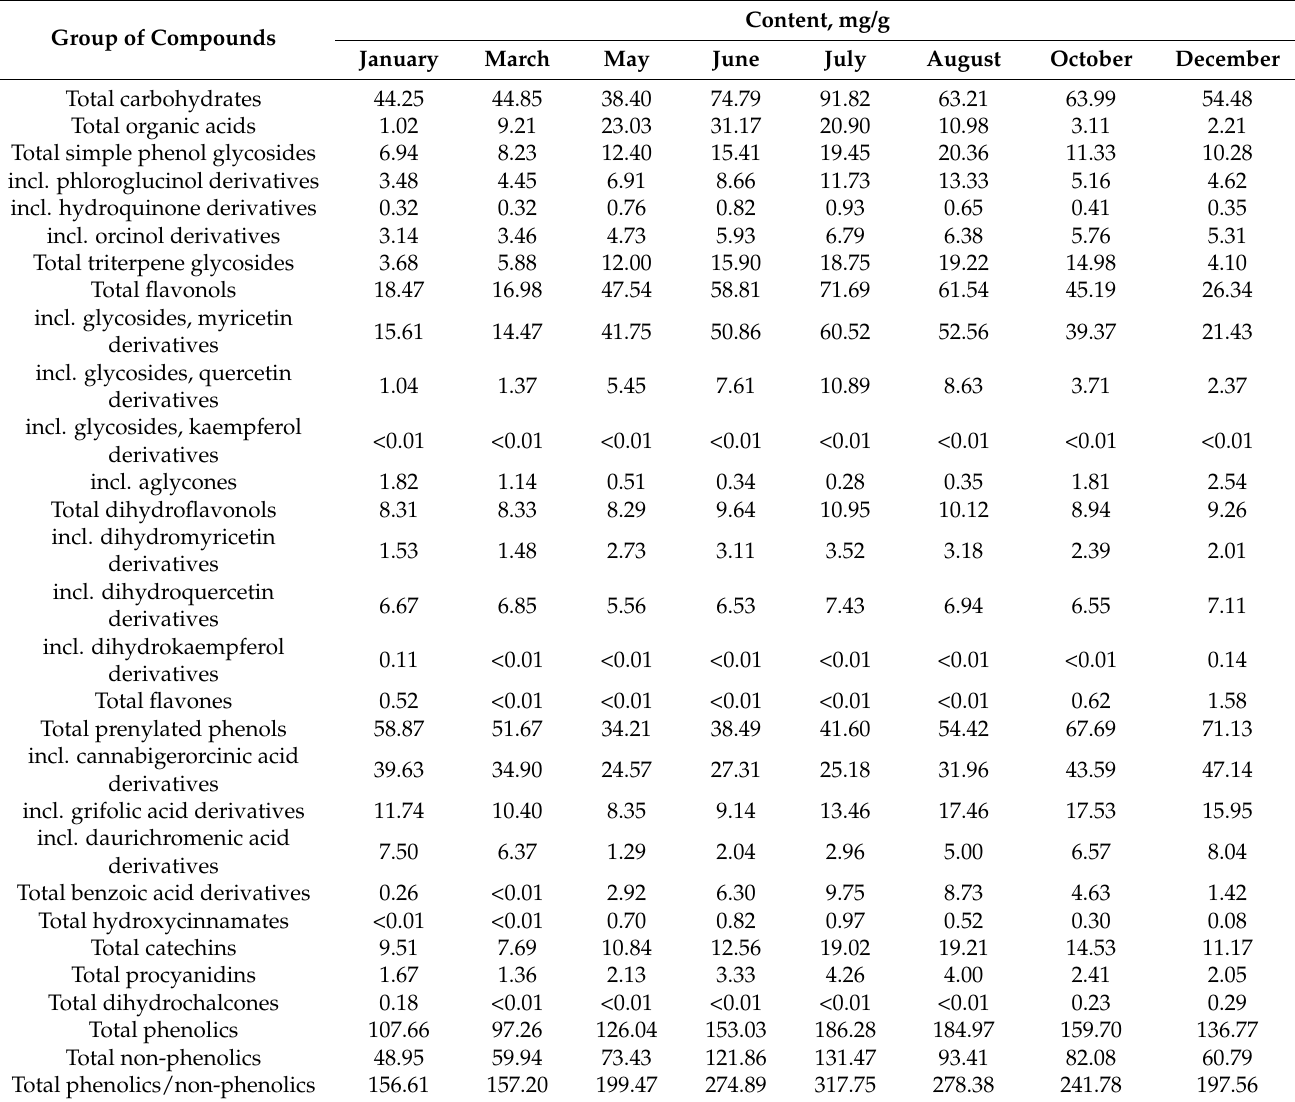
Table 4. Seasonal variation of the total content of compound groups in R. adamsii leaves, mg/g of dry plant weight. Group of